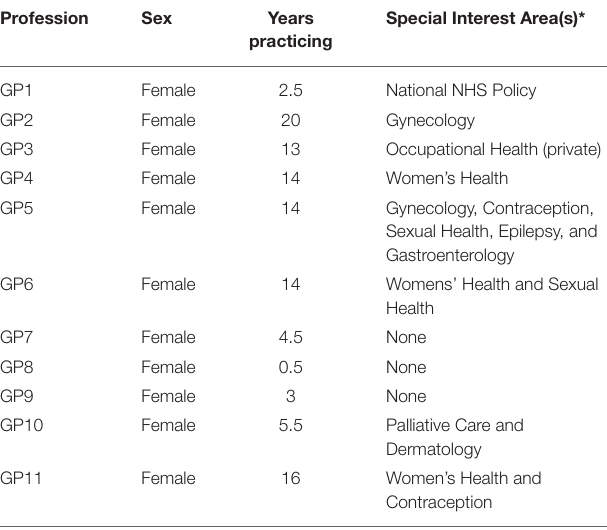
TABLE 3 | GP views of pain communication themes and